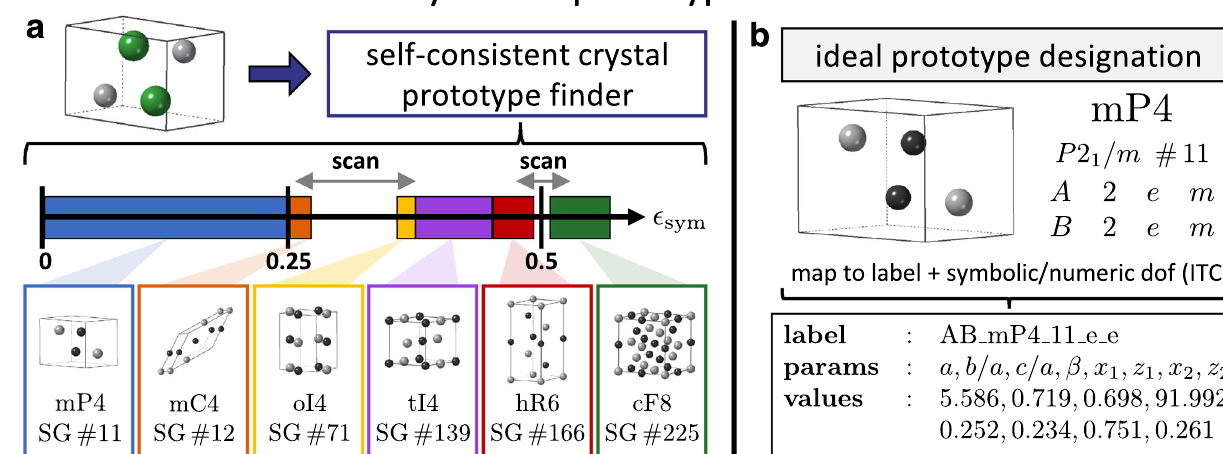
Fig. 1 Self-consistent symbolic prototype fi nder. a The prototype for an input structure, e.g. AlCl (ICSD #56541), is identi fi ed by analyzing its symmetry. Classi fi cation of the prototype may change depending on the symmetry tolerance ( ϵ sym ): mP4, SG #11 (0 < ϵ sym ≤ 0.25 Å); mC4, SG #12 (0.26 ≤ ϵ sym ≤ 0.27 Å); oI4, SG #71 (0.34 ≤ ϵ sym ≤ 0.36 Å); tI4, SG #139 (0.37 ≤ ϵ sym ≤ 0.44 Å); hR6, SG #166 (0.45 ≤ ϵ sym ≤ 0.49 Å); and cF8, SG #225 (0.51 ≤ ϵ sym ≤ 1.0 Å). An adaptive routine is employed for tolerance regions with incommensurate symmetry descriptions (gray arrows for 0.27 < ϵ sym < 0.34 Å and 0.49 < ϵ sym < 0.51 Å), ensuring self-consistent prototype/symmetry designations. b The structure is then mapped into its prototype label and symbolic and numeric internal degrees of freedom (dof), consistent with the International Tables for Crystallography (ITC). Structures in this representation can be generated with the symbolic prototype